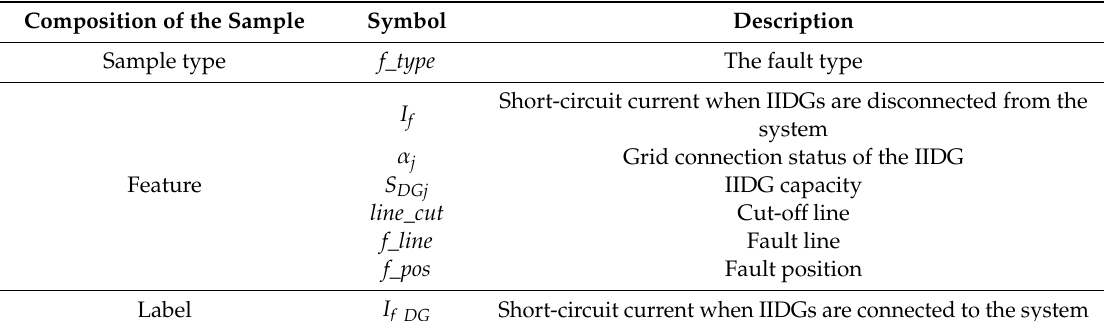
Table 1. Composition of the